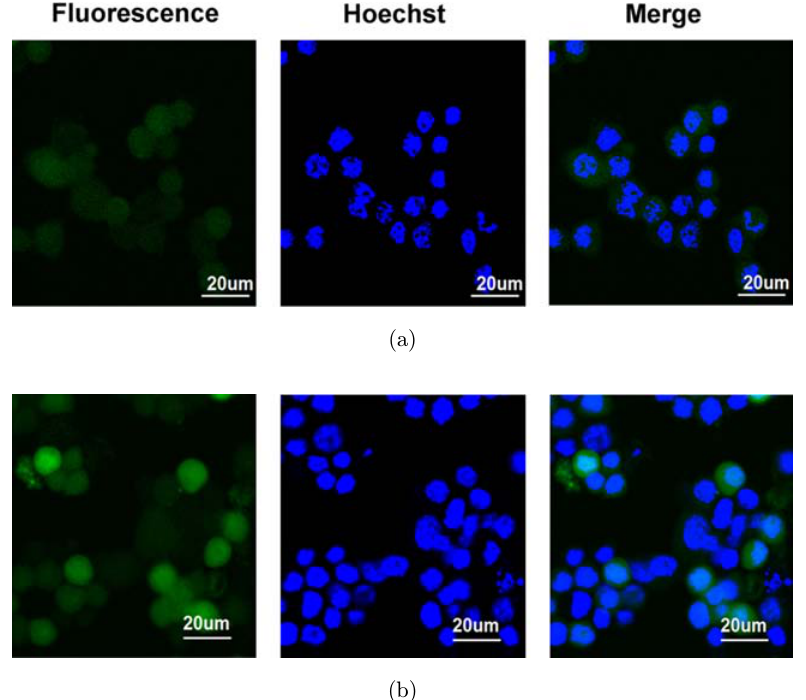
Fig. 2. Representative laser confocal °uorescence microscopy images of RAW 264.7 cells incubated with (a) unmodi¯ed micelles and (b) folate modi¯ed